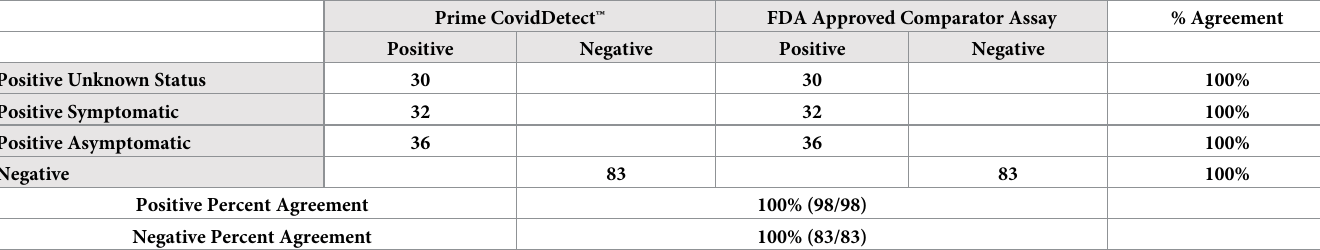
Table 7. Evaluation of clinical samples and comparison to the Zymo FDA-Approved comparator